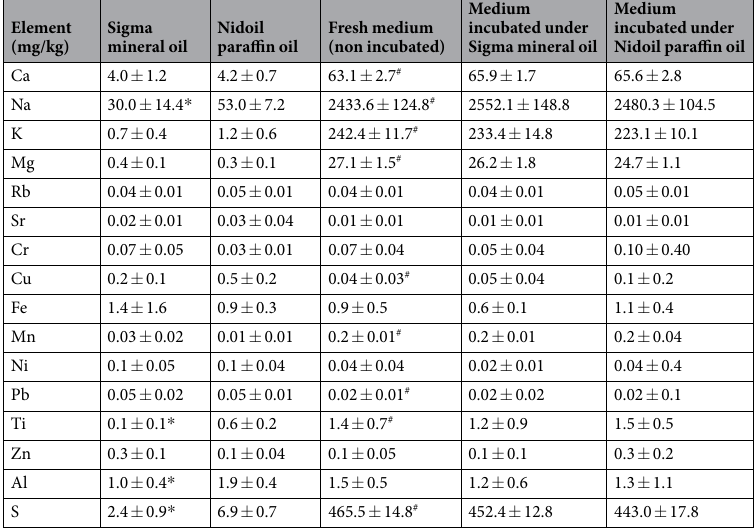
Table 2. Inorganic element concentrations in 5 days incubated mineral oil, paraffin oil, and embryo culture medium covered with mineral and paraffin oils. * Indicate differences (P < 0.03) between Sigma mineral and Nidoil paraffin oils. # Indicate differences (P < 0.05) between fresh culture medium and Sigma mineral and Nidoil paraffin oils. There were no differences in element concentrations between fresh culture medium and incubated culture medium covered with Sigma mineral or Nidoil paraffin oil. Values are means ± SD (four replicates).